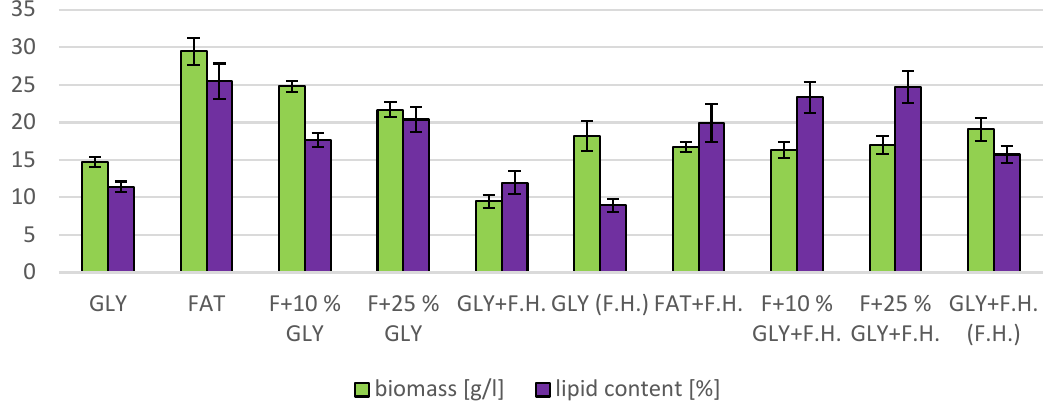
Figure 11. Lipid and biomass content in yeast strain R. mucilaginosa at C/N ratio 25.